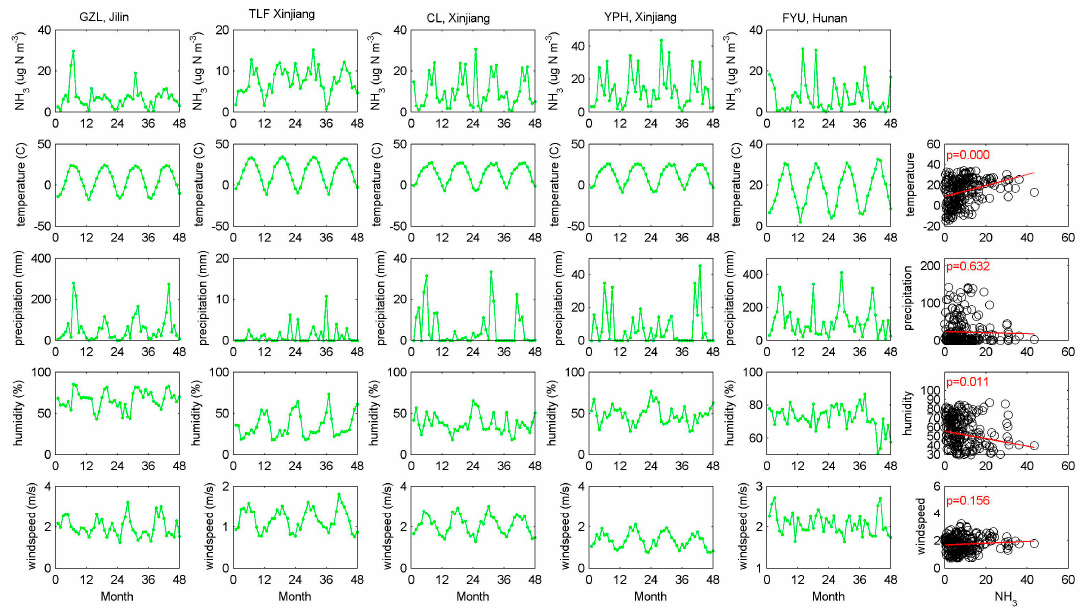
Figure 7 . The seasonal variations of ground NH 3 concentrations (µg N m − 3 ), temperature (°C), precipitation (mm), humidity (%), and wind speed (m/s) at five sites with best-simulated ground NH